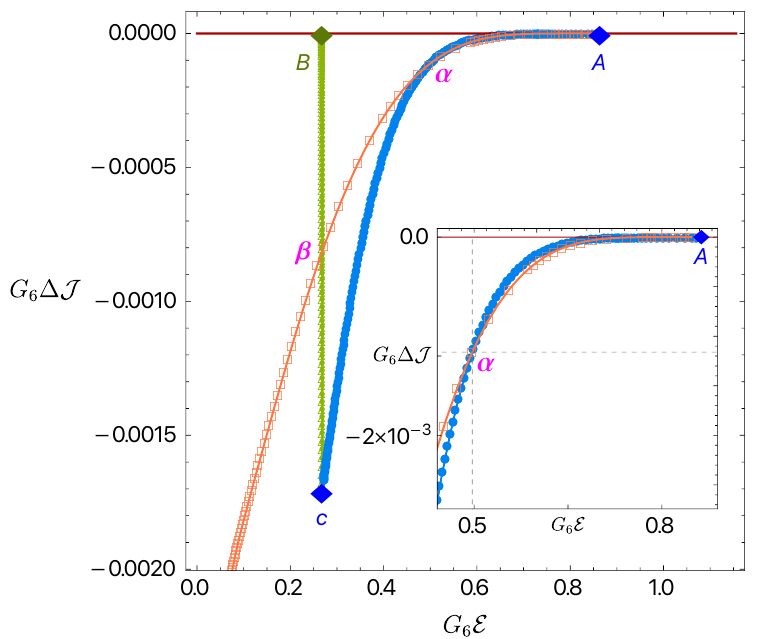
Figure 3 . Superradiant instability (for m = 2 ) and Gregory-Laflamme instability of Myers-Perry black strings with parameters E , J . For presentation, we show the momentum difference with the extremal Myers-Perry black string G 6 ∆ J ≡ G 6 ( J − J ) . Superradiant instability occurs ext MP same E inside the triangular region ABc , and Gregory-Laflamme instability occurs above the curve marked by orange squares. The Gregory-Laflamme onset curve intersects with the edge of the unstable superradiant region at points α and β . The horizontal red line at ∆ J = 0 is extremality. √ 2 e Ω H = e Ω ext H = 1 /